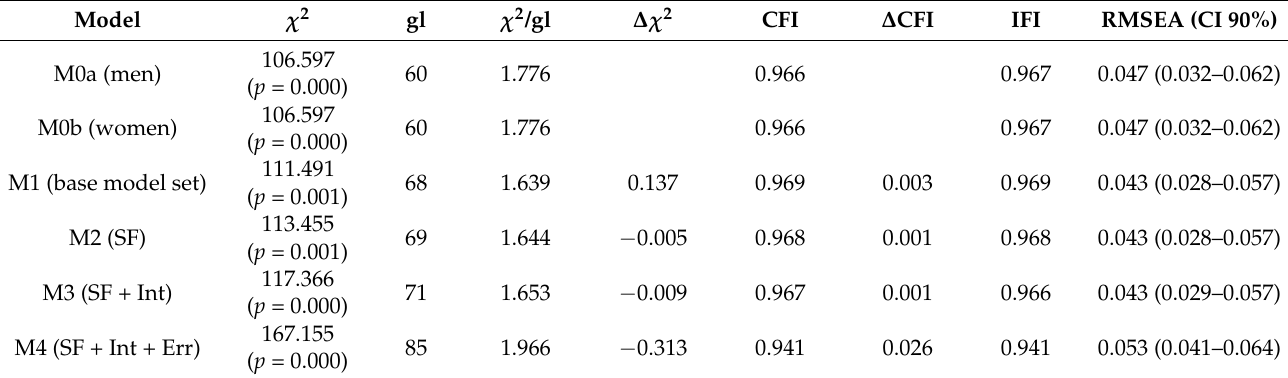
Table 2. Multigroup analysis of invariance across sex